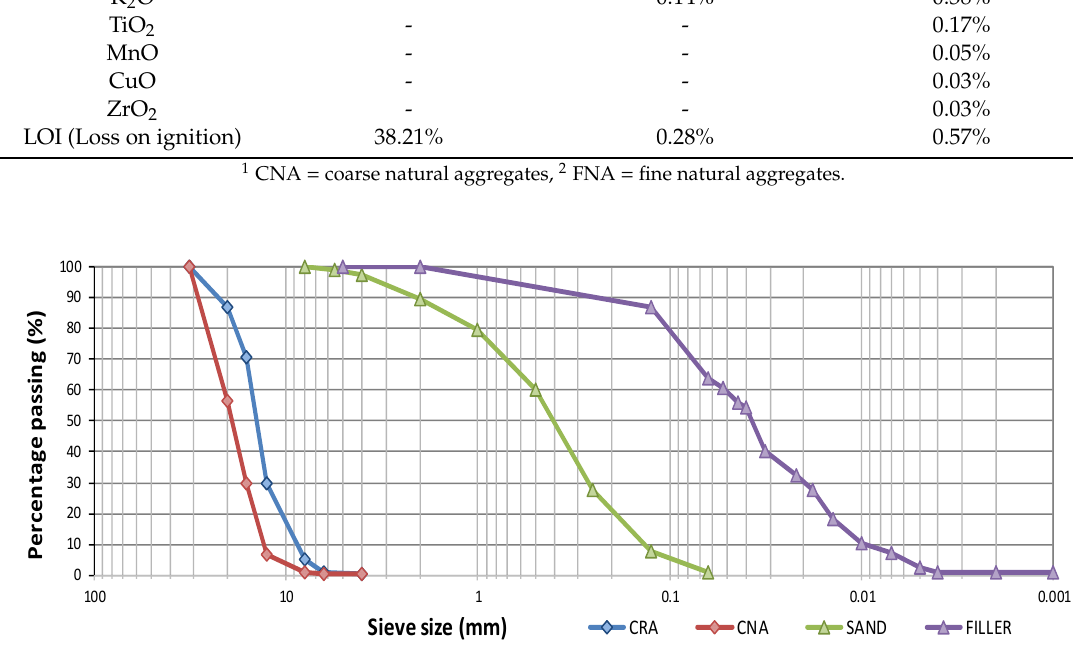
Table 2. Chemical composition: natural lime filler, coarse natural and fine natural aggregates Chemical